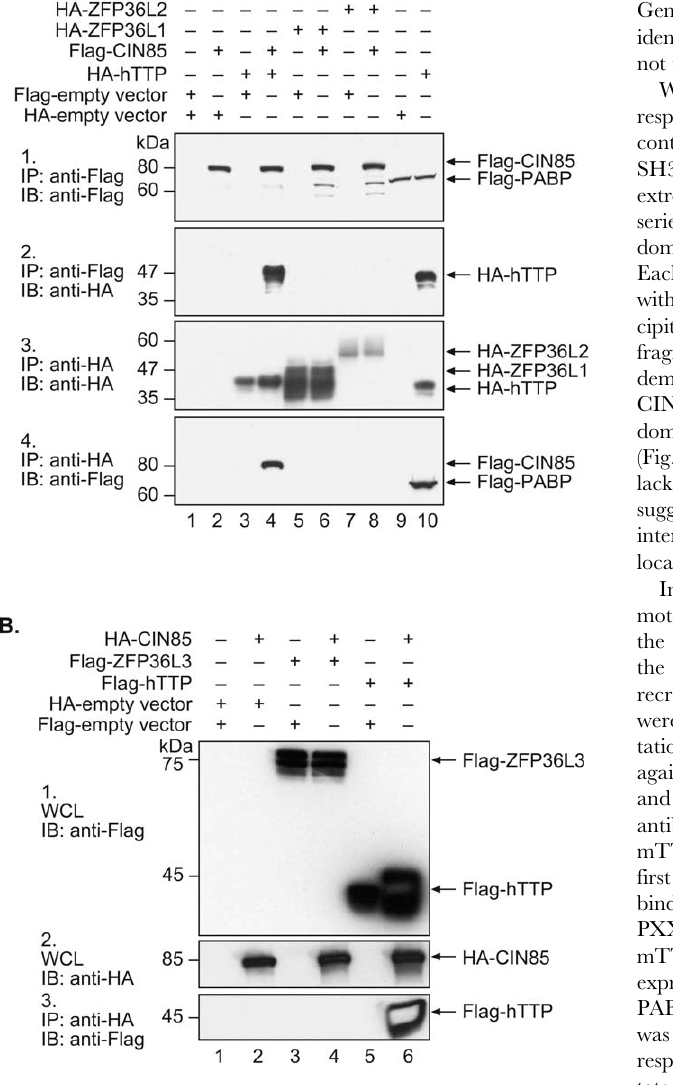
Fig. 4A2, lane 2) C-terminal amino acids in hTTP, in both cases removing the PXXXPR motif, completely eliminated the binding,